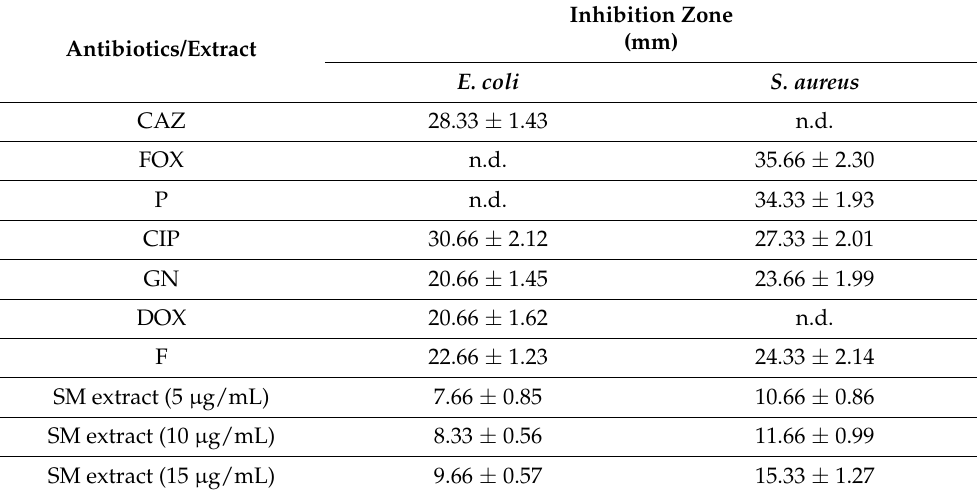
Table 2. Antimicrobial activity against Gram-negative ( E. coli ) and Gram-positive ( S. aureus ) bacte- ria of the different concentrations of SM extract (5 µg/mL, 10 µg/mL, and 15 µg/mL) compared to the following antibiotics: 10U Penicillin (P), 30 µg Doxycycline (DOX), 10 µg Gentamicin (GN), 30 µg Ceftazidime (CAZ), 300 µg Nitrofurantoin (F), 5 µg Ciprofloxacin (CIP), and 30 µg Oxacillin (FOX).